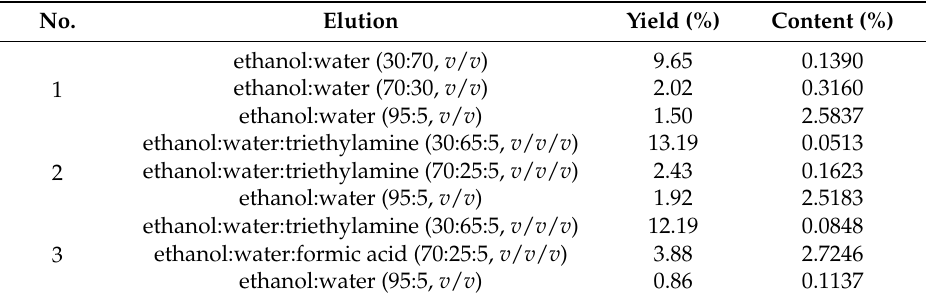
Table 2. Effect of the elution solvent on total alkaloids yield and CEP content yield from S. cepharantha . No. Elution Yield (%)